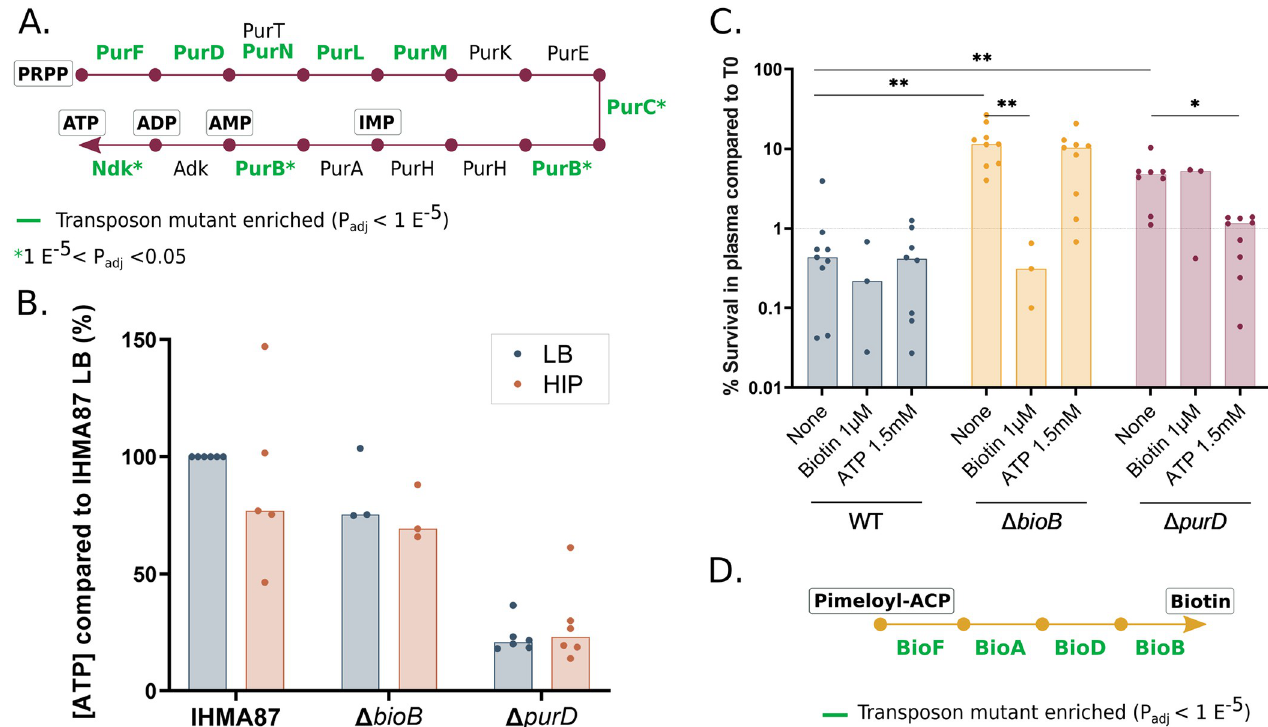
Fig 4. ATP and biotin influence bacterial sensitivity to plasma. A. Schematic view of the purine pathway (adapted from KEGG database [42]). Significantly enriched insertions in corresponding genes of the Tn-seq screen are indicated . B. Measurement of intra-bacterial ATP levels in LB and after 2h-incubation in HIP normalized to the CFU counts. C. Trans-complementation of Δ bioB and Δ purD phenotype by exogenous biotin or ATP, respectively. Biotin (1 μ M) and ATP (1.5 mM) were added at the beginning of the incubation of bacteria in plasma. The survival was estimated by CFU counting and the median of all independent experiments is represented by the histogram. Statistical analysis was performed and p-value < 0.05 or 0.01 are indicated with ‘ � ’ and ‘ �� ’, respectively. D. The biotin biosynthetic pathway. Significantly enriched hits in Tn-seq are highlighted in green.